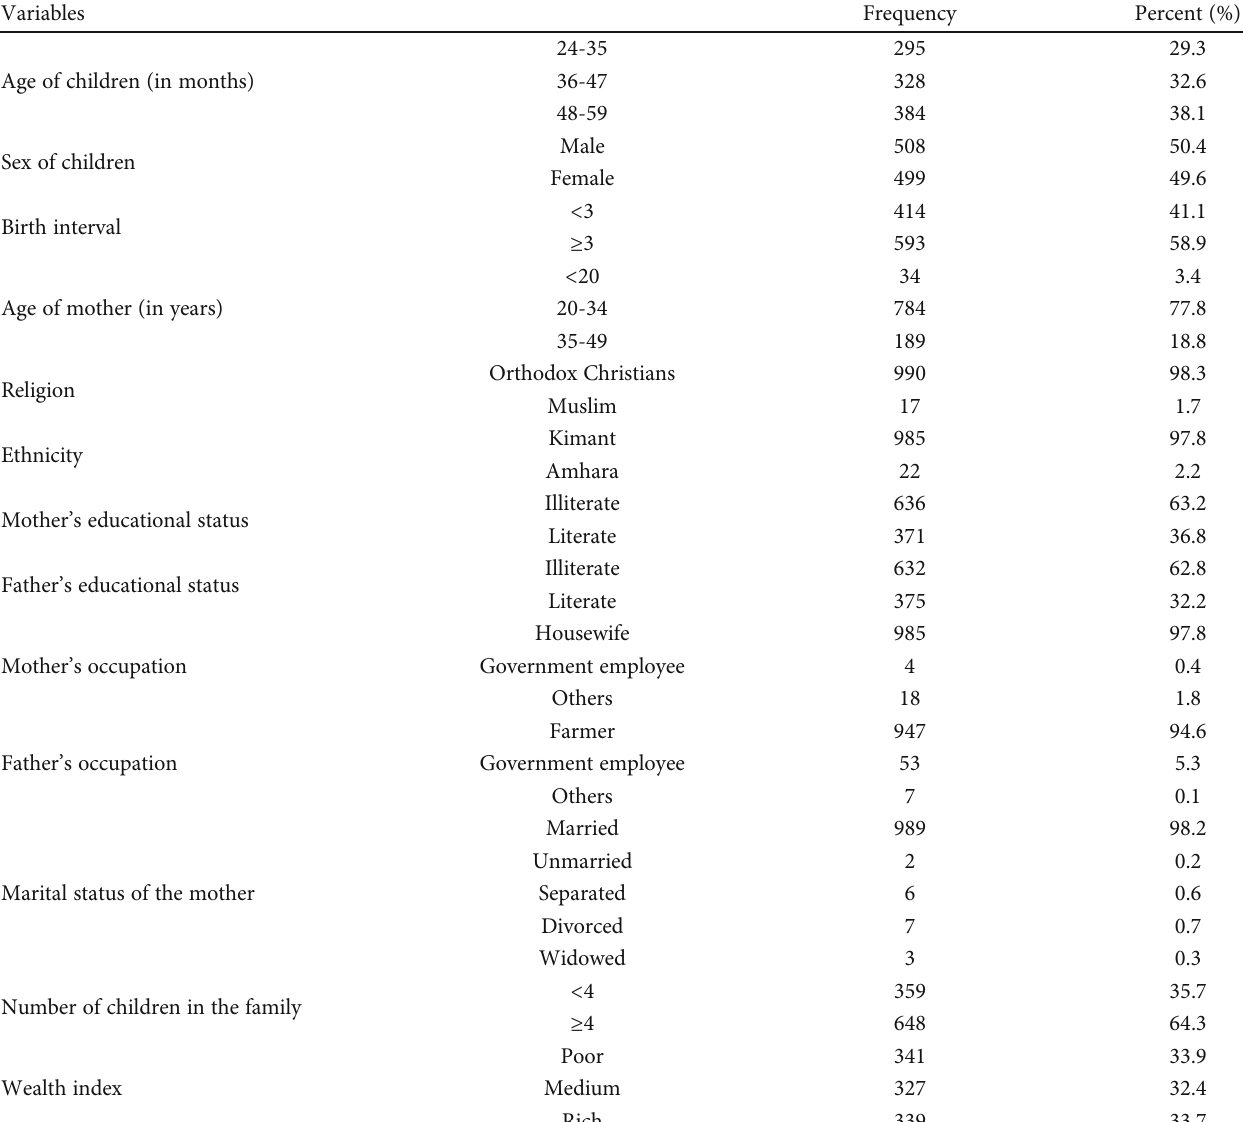
Table 1: Sociodemographic and economic characteristics among children aged 24-59 months in Lay Armachiho District, Central Gondar Zone, northwest Ethiopia,